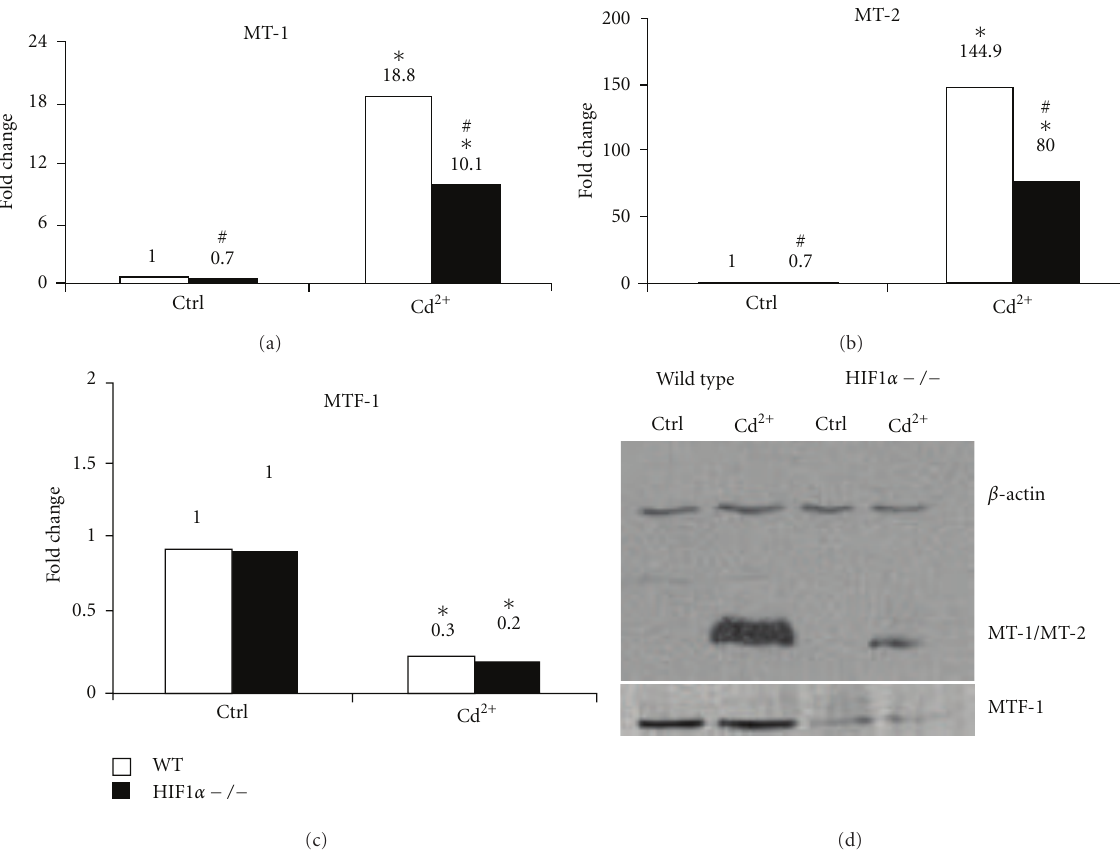
Figure 4: Cadmium-induced changes in metallothionein and MTF-1. Wild-type (WT, white bars) and HIF1 α − / − (black bars) cells were left untreated (Ctrl) or 5 μ M CdCl 2 (Cd 2+ ) for 24 hours. Metallothionein-1 (A, MT-1), Metallothionein-2 (B, MT-2), and Metal Transcription Factor-1 (C, MTF-1) mRNA levels were measured using qRT-PCR. All values were normalized to wild-type control. The number above each bar is the fold change for that particular treatment. ∗ P < 0 . 05 compared to respective controls, # P < 0 . 05 compared to wild-type cells within treatment group, n = 6. G. Metallothionein-1/2 (middle panel) and MTF-1 (lower panel) protein levels were determined in wild-type and HIF1 α − / − cells after treatment with 5 μ M CdCl 2 (Cd 2+ ) for 24 hours. β -actin was used as a loading control (upper